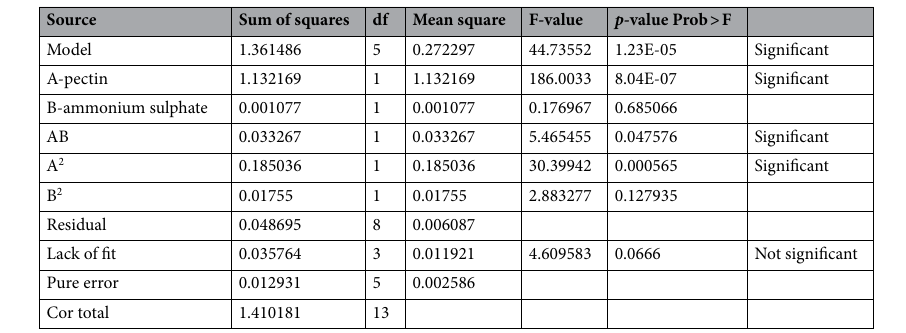
Table 8. ANOVA for response surface quadratic model for the pectate lyase